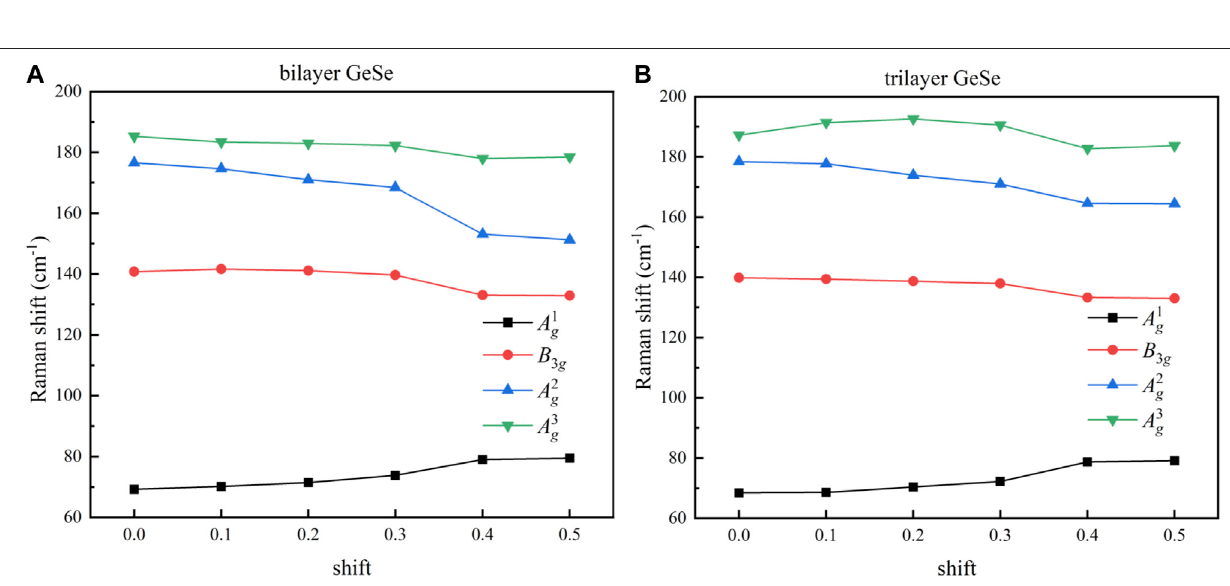
Frontiers in Materials |